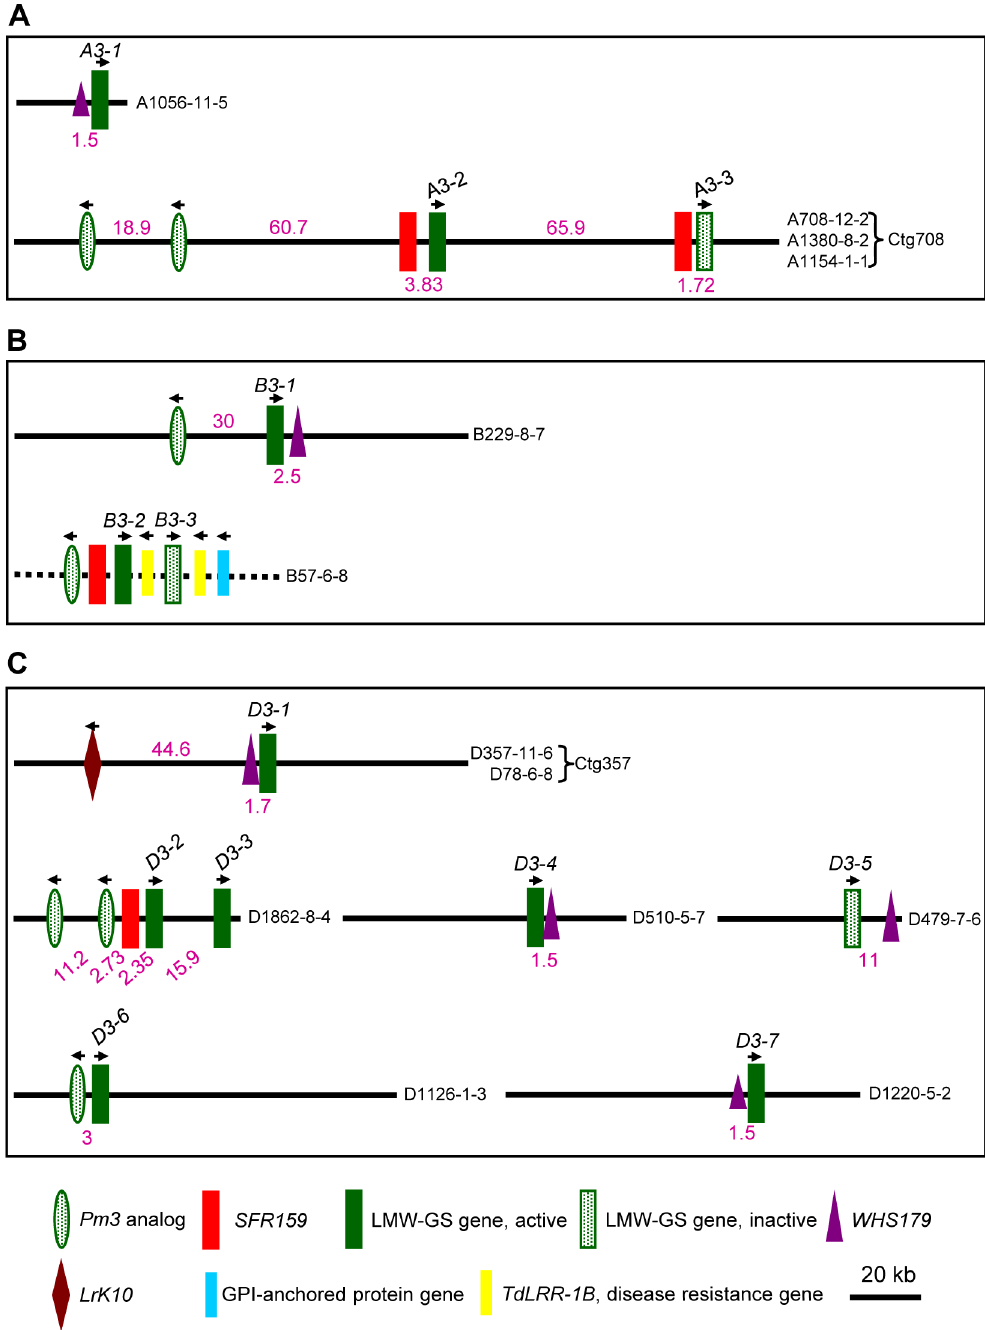
Figure 1. The organizations of LMW-GS genes of Xiaoyan 54 in 13 representative BAC clones. Diagrams illustrating the organizations of the LMW-GS genes (including both active and inactive members) of Xiaoyan 54 in 13 representative BAC clones, in relation to the markers ( SFR159 and WHS179 ) and genes ( LrK10 , Pm3 analog, TdLRR-1B disease resistance gene, and the gene encoding GPI-anchored protein) found in the vicinities of LMW-GS genes in previous studies. Sequence gaps exist in the BAC clone B57-6-5 (drawn as a dashed line). The remaining 12 BAC clones were fully sequenced. If available, the physical distances (kb) between two neighboring genes or between a marker and its adjacent gene are given (in purple). The arrows indicate the predicted transcriptional directions of the genes. (A) The organization patterns of three Glu-A3 LMW-GS gene members. A WHS179 marker was present in BAC clone A1056-11-5, and its physical distance to A3-1 was 1.5 kb. A3-2 and A3-3 occur in the BAC contig Ctg708 formed by three BAC clones (A708-12-2, A1380-8-2, A1154-1-1). (B) The organization patterns of three Glu-B3 LMW-GS gene members ( B3-1 , B3-2 , B3- 3 ). The physical distances between neighboring genes or the adjacent gene and marker were not determined in B57-6-5 because of the presence of sequence gaps. (C) Organization patterns of seven Glu-D3 LMW-GS gene members ( D3-1 , D3-2 , D3-3 , D3-4 , D3-5 , D3-6 , D3-7 ). D3-1 was found in the contig Ctg357 composed of two BAC clones (D357-11-6, D78-6-8).